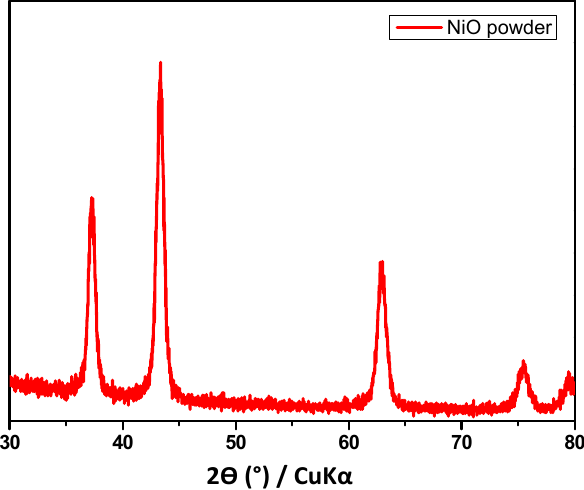
Figure 5. XRD pattern of NiO powder .